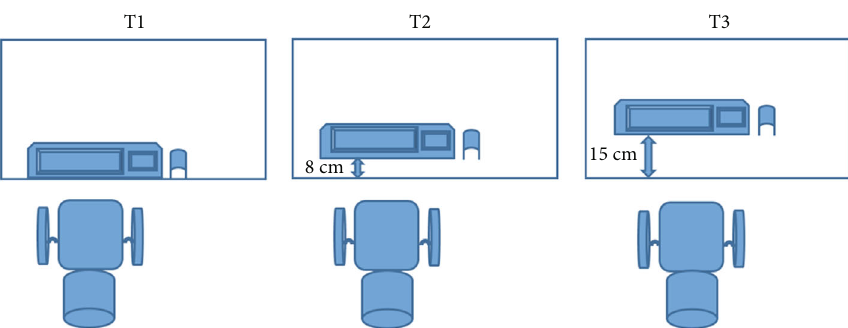
Figure 2: The three distances of the keyboard. T1: keyboard positioned at the edge of the desk, T2: 8cm away from the edge of the desk, and T3: keyboard positioned at 15cm away from the edge of the